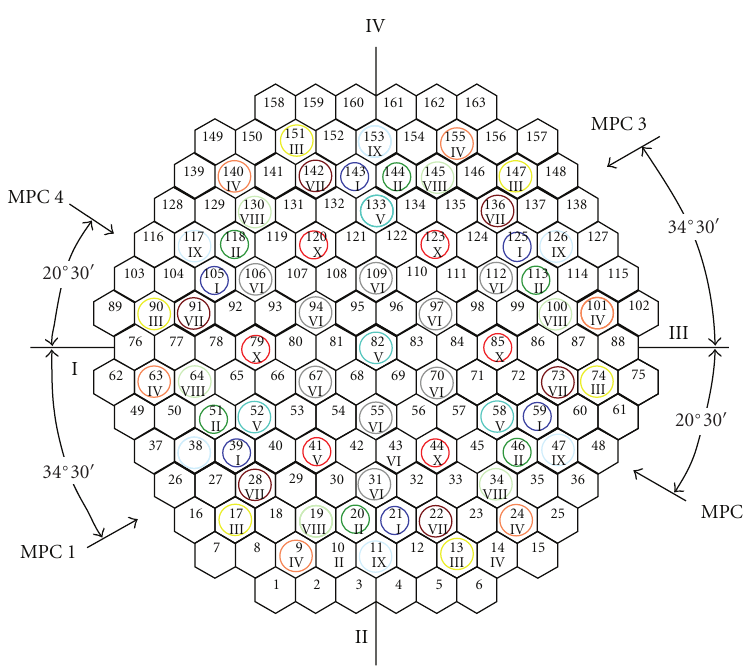
Figure 2: The asymmetrical arrangement of the loops (I, II, III, and IV) related to the